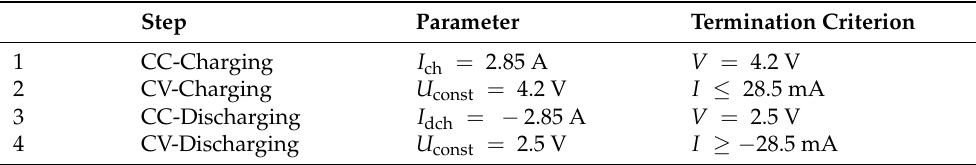
Table 2. Consistent measurement procedure for each measured position around the circumference of the battery